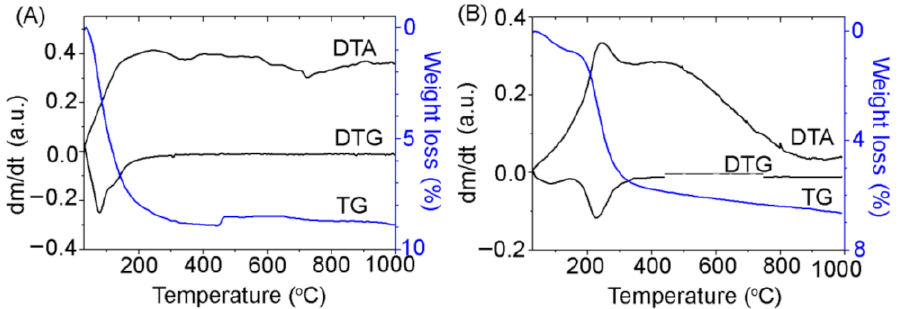
Figure 6. Differential thermal analysis (DTA), differential thermogravimetric analysis (DTG), and thermogravimetric (TG) curves for CeO 2 ( A ) and P/CeO 2 (0.6 mmol/g) ( B